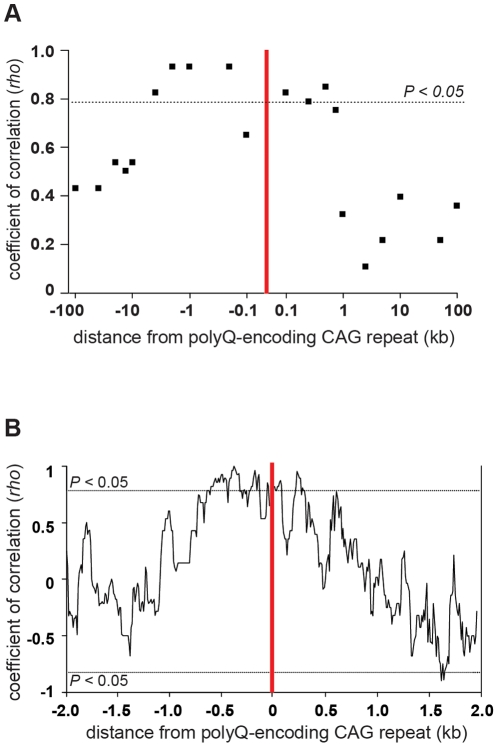
Repeat expandability correlates with flanking genomic DNA sequence GC content.(A) polyQ-encoding CAG-repeat expandability correlates with proximal, but not distal flanking genomic DNA sequence GC content. Distance from the repeat (red vertical line) is plotted on a log scale against Spearman's coefficient of correlation (rho) with expandability [31]. The dashed line shows the threshold for statistical significance (P<0.05; two-tailed). (B) The graph shows the coefficient of correlation of flanking genomic DNA GC content of the seven dynamic DNA CAG polyQ-encoding loci with repeat expandability. Spearman's rank coefficient of correlation (rho) was calculated to a distance of 2,000 bp both 5′ and 3′ of each repeat using a sliding window of 100 bp and step size of 10 bp. The dashed line shows the threshold for statistical significance (P<0.05; two-tailed). and The position of the CAG•CTG repeat is represented by the vertical red bar.